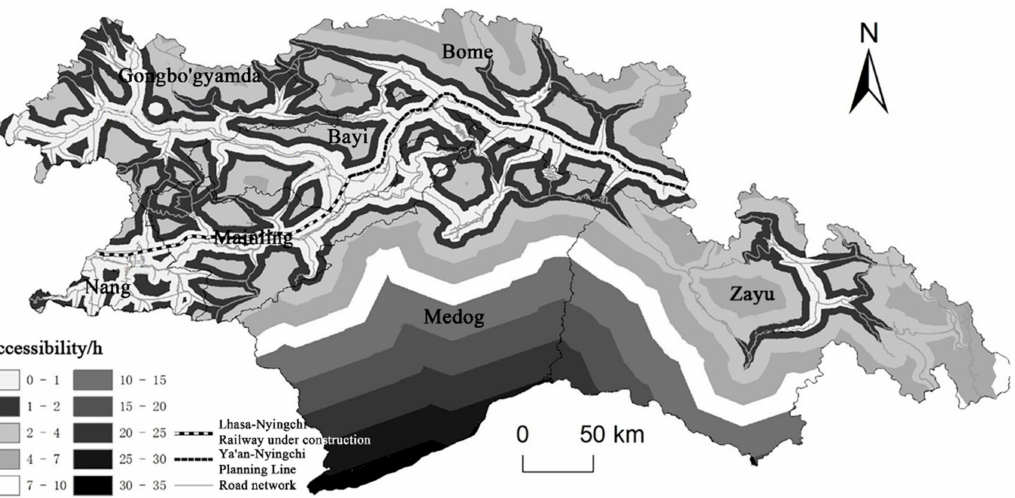
Figure 7. Comprehensive accessibility under the condition of perfect highway and railway with tourist attractions as the core. Note: This map is based on the standard map of the Map Technical Review Centre of the Ministry of Natural Resources of China (Number: GS (2019)4342), with no modifications to the base map. Map-making by the author.